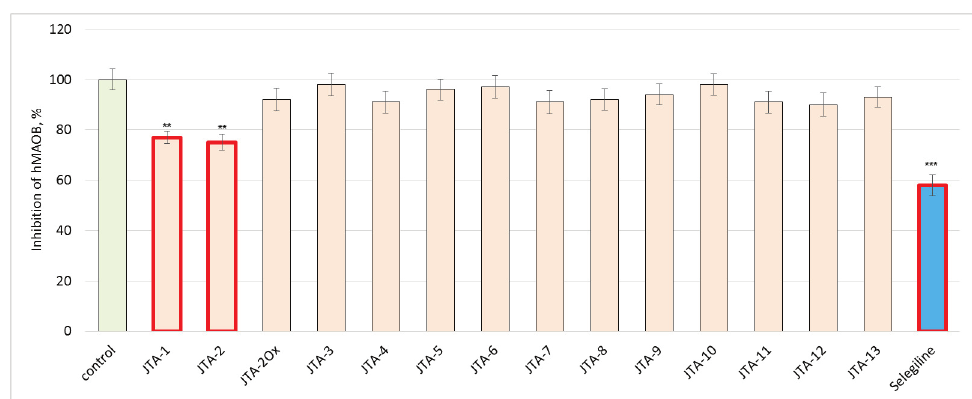
FIGURE 7 - Effects of caffeine-8-thioglycolic acid (KTG) derivatives and selegiline (at concentration 1 μM), on hMAOB enzyme. Mean ± SEM (n = 6). ** P < 0.01; *** P < 0.001 vs control (pure